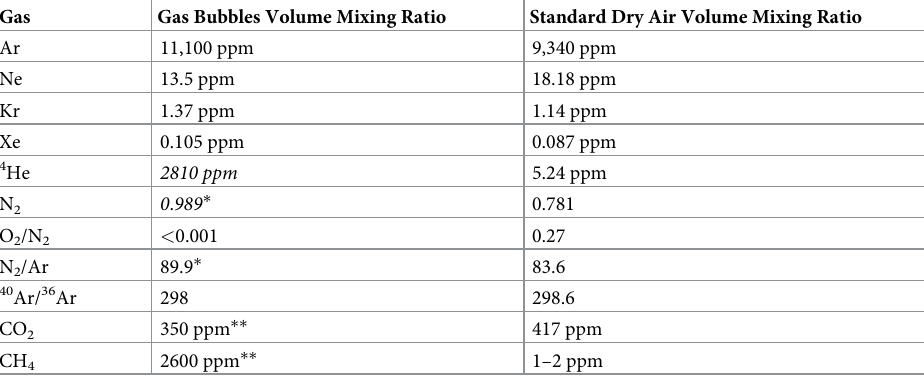
Table 1. Summary of data for gas in bubbles.